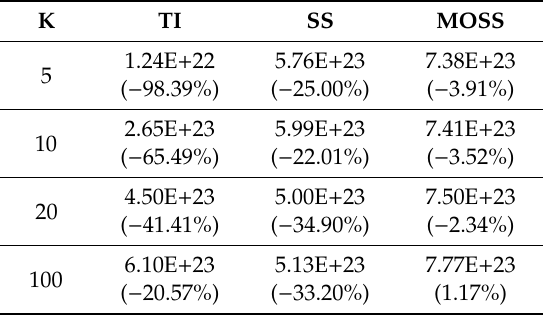
Table 5. BME (BME Relative Error [%]) for ADE2 model using thermodynamic integration (TI), steppingstone sampling (SS), and multiple one-steppingstone sampling (MOSS), for n = 20,000 number of samples per K interval. The reference BME solution is 7.68 × 10 23 ± 7.34 × 10 21 , and the 95% credible interval of the reference solution error is ± 1.57%.